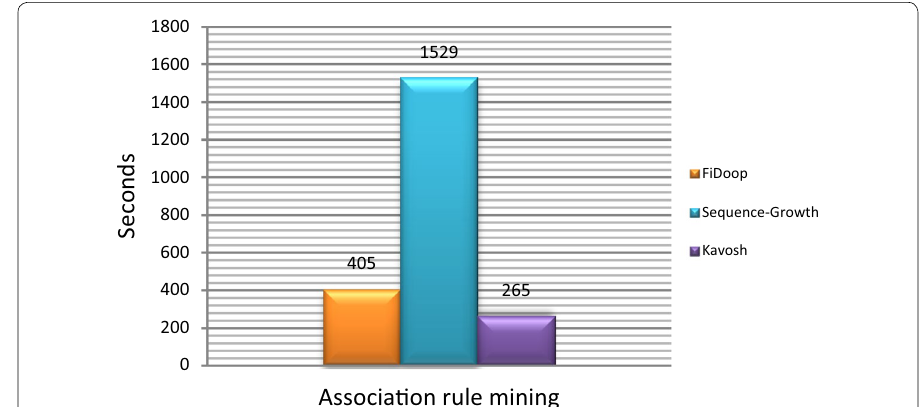
Fig. 10 Association rule mining execution time